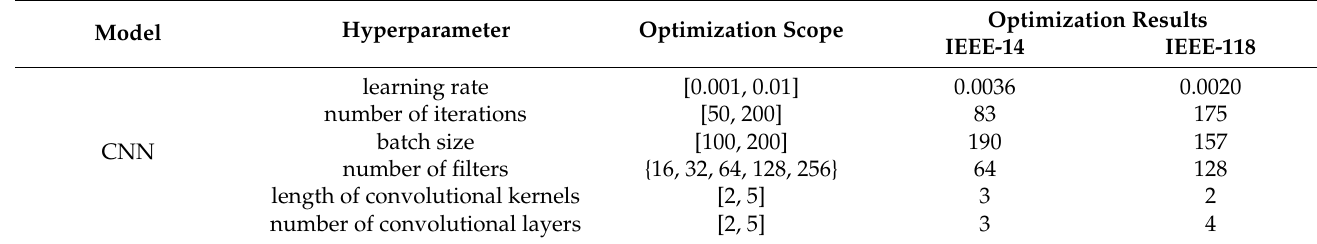
Table 2. SSA optimized hyperparameters of the CNN